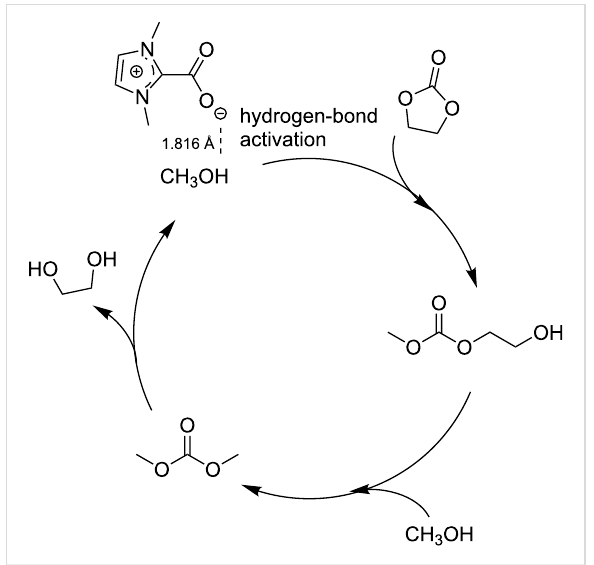
Scheme 17: A simplified reaction mechanism for DMC